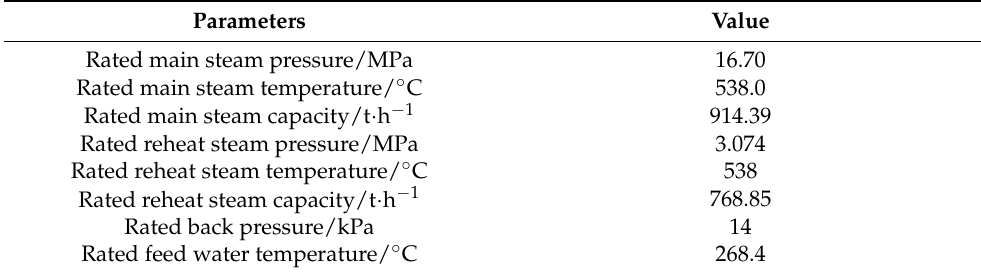
Table 2. Turbine Table 2. Turbine parameters.